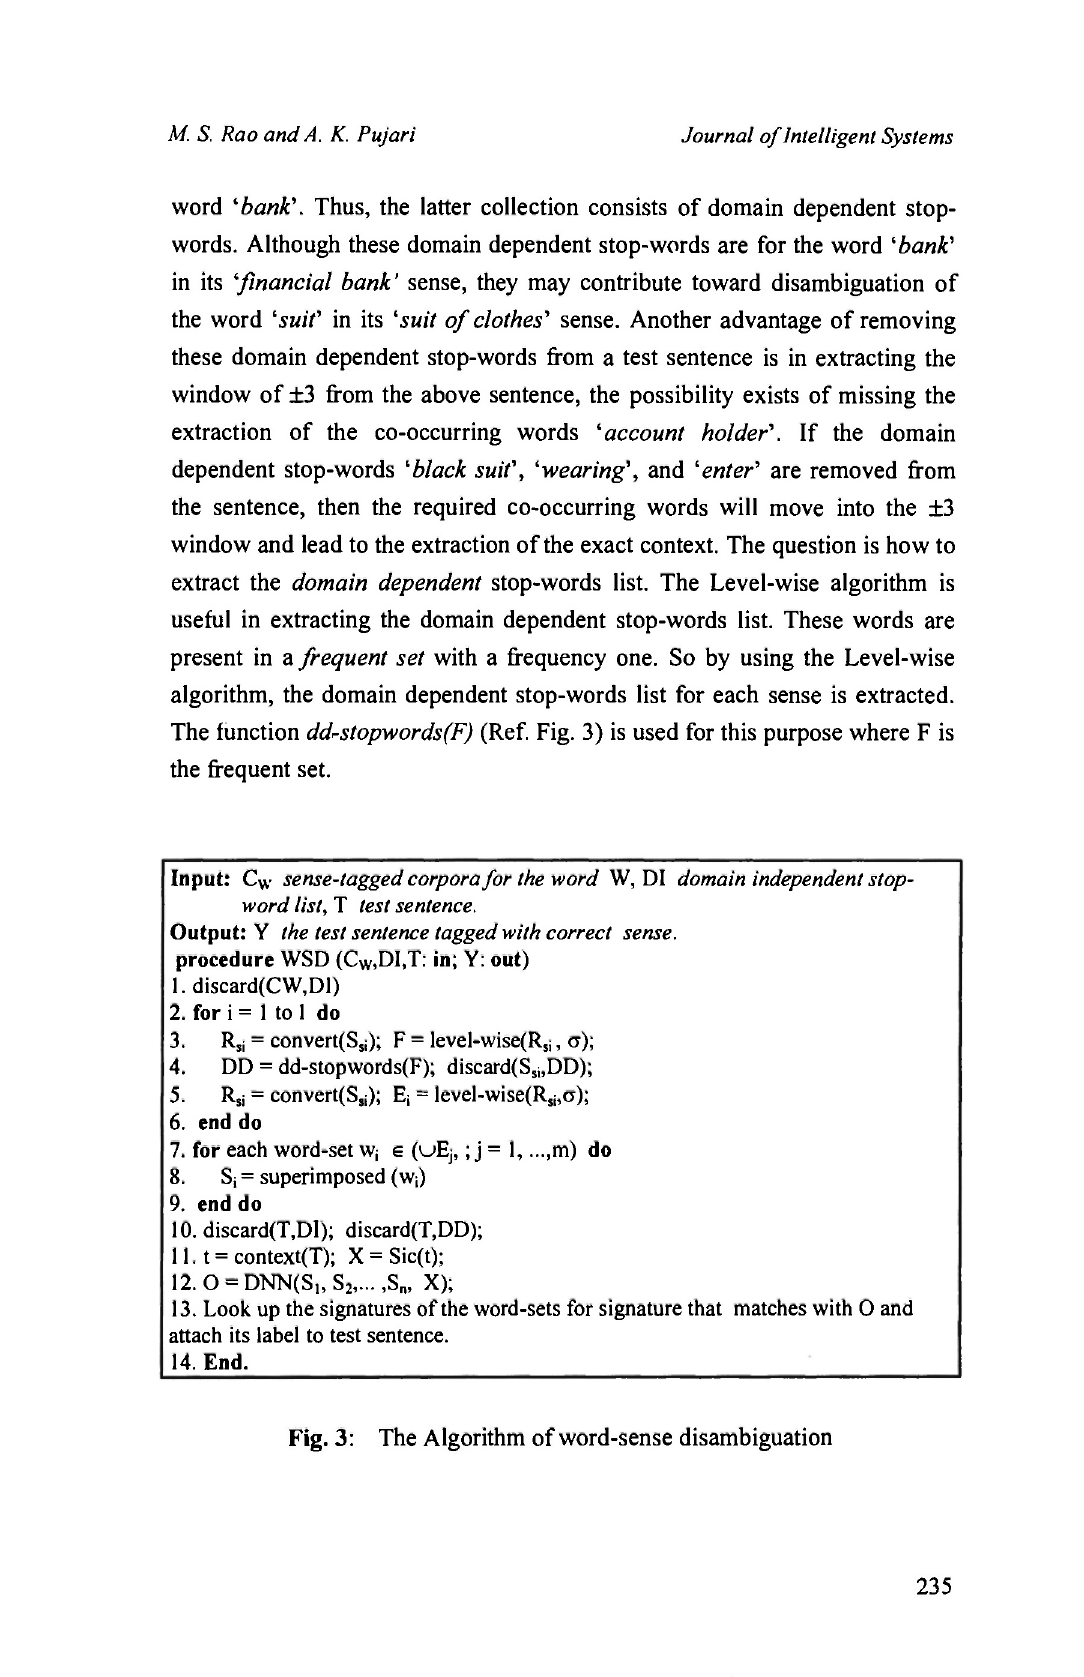
Fig. 3: The Algorithm of word-sense